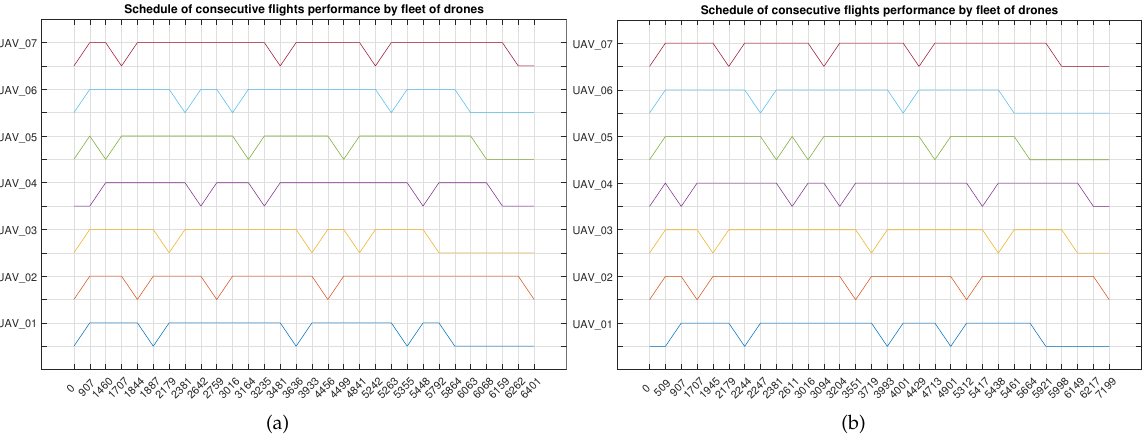
Figure 2. Schedule of consecutive flights performance by fleet of seven drones. ( a ) the shortest and ( b ) the longest